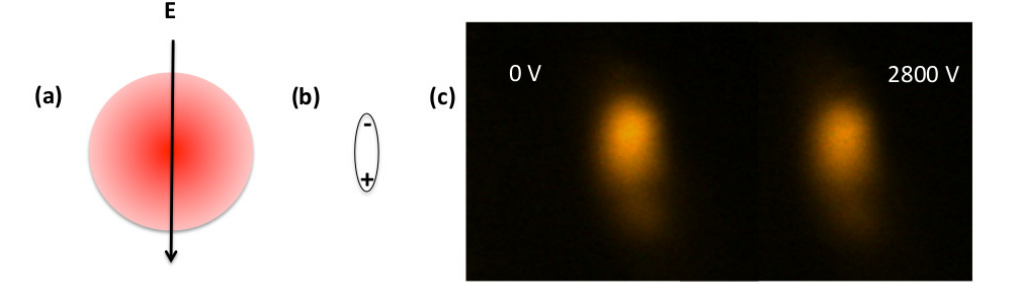
Figure 1. ( a ) The MOT at the center of the vacuum chamber and the electric field is added across the MOT as shown by E . ( b ) One atom in the MOT is polarized under the electric field; ( c ) two images taken at a zero field and 1100 V/cm or 2800 V on two pairs of rods which are 1 inch apart. Each image is 184 pixels × 208 pixels